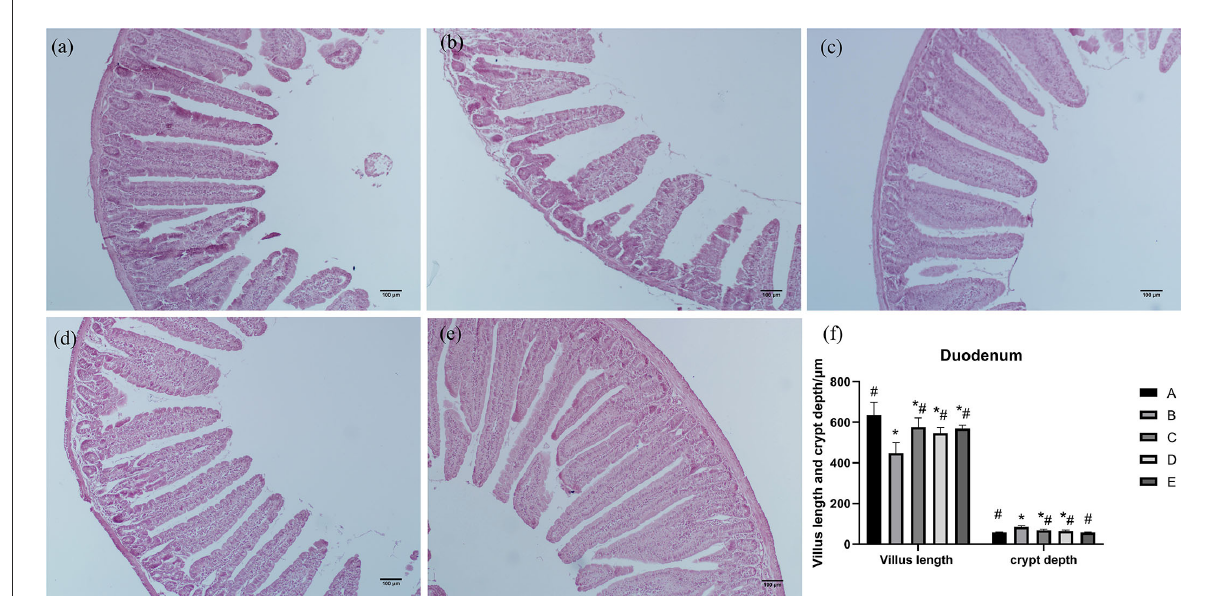
FIGURE1 Effects of CSPCM on the morphological features of the duodenum. (a) Morphological observation of duodenum in group A. (b) Morphological observation of duodenum in group B. (c) Morphological observation of duodenum in group C. (d) Morphological observation of duodenum in group D. (e) Morphological observation of duodenum in group E. (f) Effect of CSPCM on duodenal villus length and crypt depth. * Significant difference with group A ( P < 0.05). # Significant difference with group B ( P <